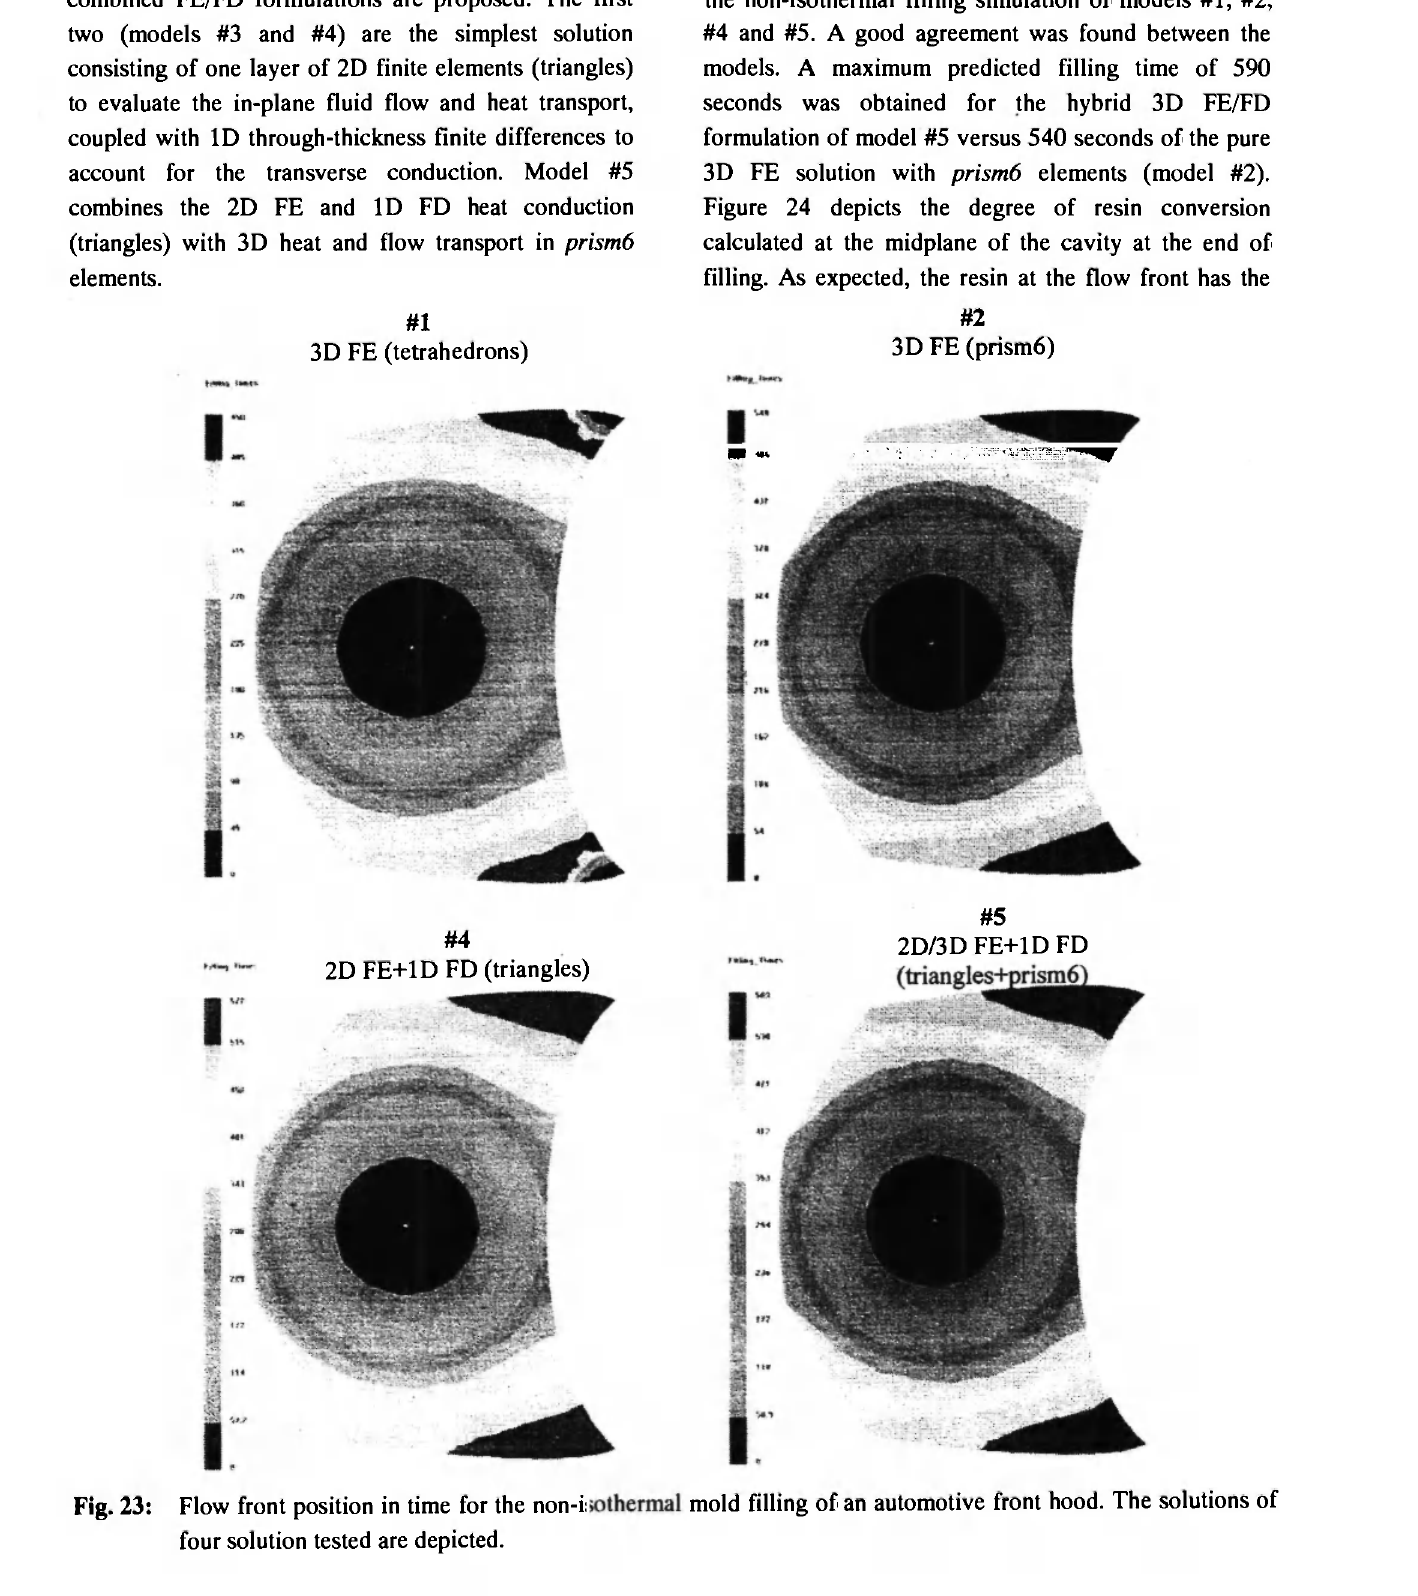
Fig. 23: Flow front position in time for the non-i: four solution tested are depicted.